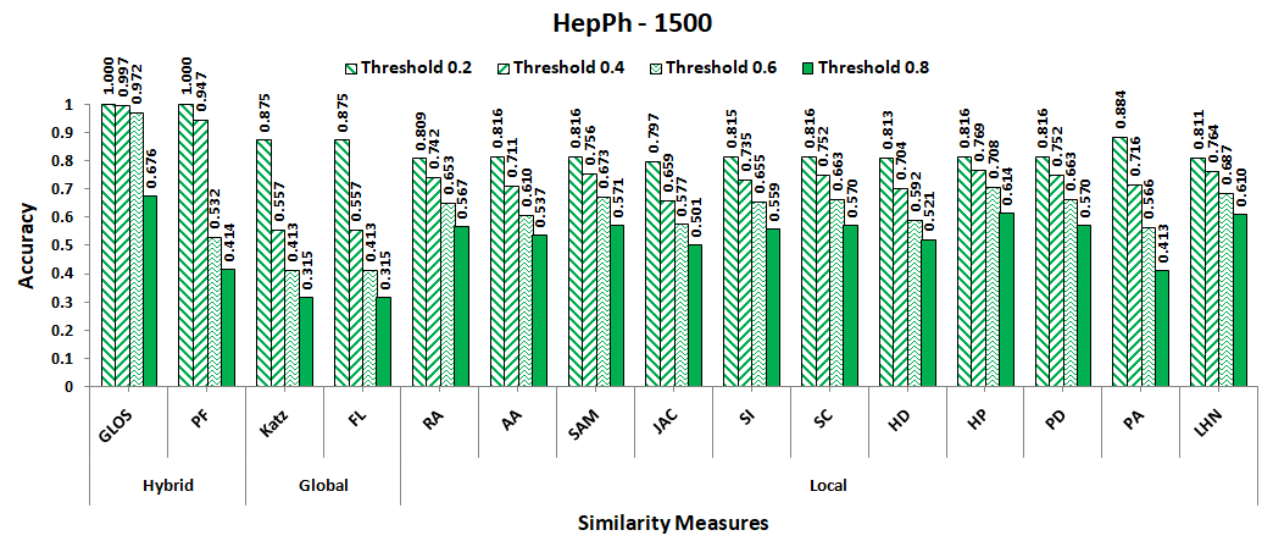
Figure 17. Comparisons of similarity measures on HepPh-1500 edge list from HepPh